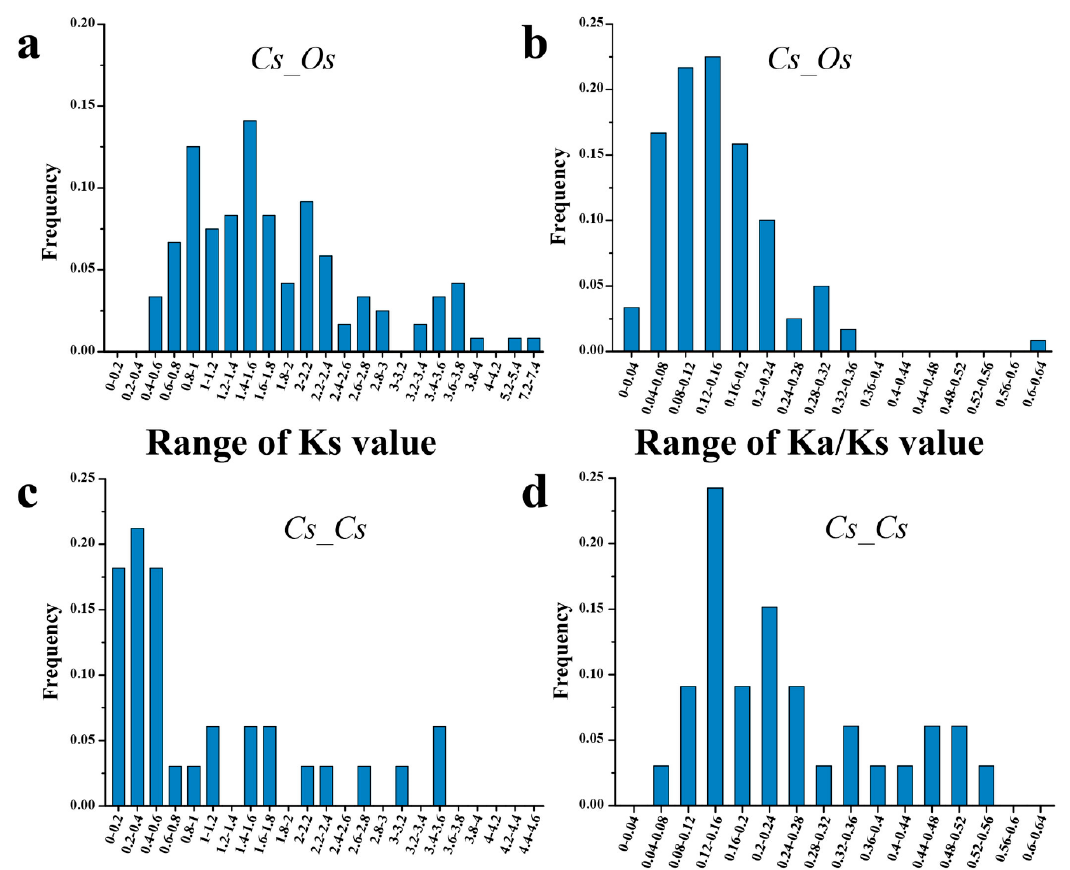
Figure 3. Ks and Ka/Ks value distributions of the NAC members in C. songorica and rice genomes. Figure 3. Ks and Ka / Ks value distributions of the NAC members in C. songorica and rice genomes. The distribution of Ks and Ka/Ks values of orthologous genes between C. songorica and rice ( a ) and The distribution of Ks and Ka / Ks values of orthologous genes between C. songorica and rice ( a , b ) and ( b ) and paralogous genes in C. songorica ( c ) and ( d ). paralogous genes in C. songorica ( c , d